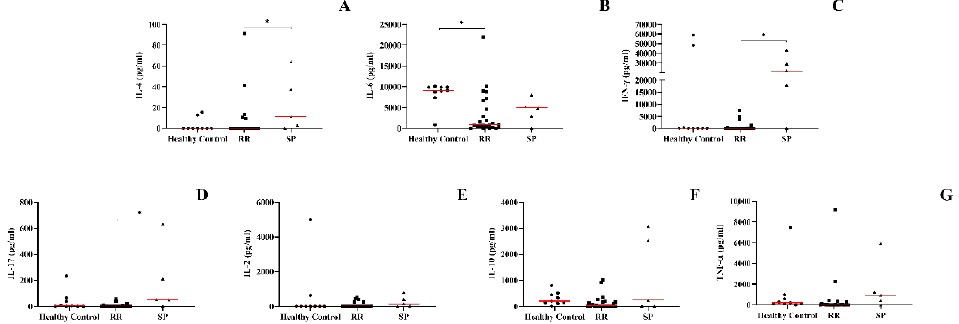
Figure 2. Concentration of cytokines through cultures of PBMCs derived from peripheral blood of the patient groups evaluated by CBA (cytometric bead array): Healthy control, RR (patients with relapse–remitting multiple sclerosis), SP (patients with secondary progressive multiple sclerosis). ( A ) IL-2, ( B ) IL-4, ( C ) IFN- γ , ( D ) IL-10, ( E ) IL-17, ( F ) TNF- α , and ( G ) IL-6. Rows represent the median. Statistical analysis was performed using the Kruskal–Wallis test with Dunn’s post-test, where * p < 0.05.